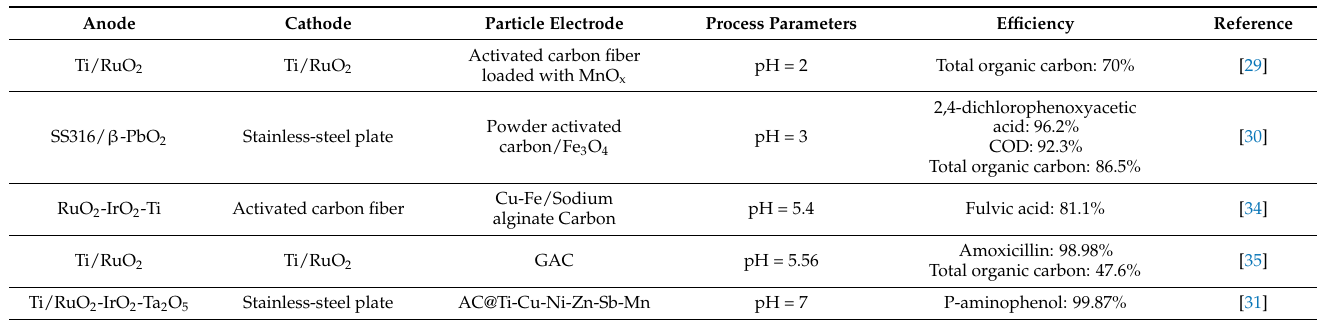
Table 1. Some typical 3D-EF works at different pH values.